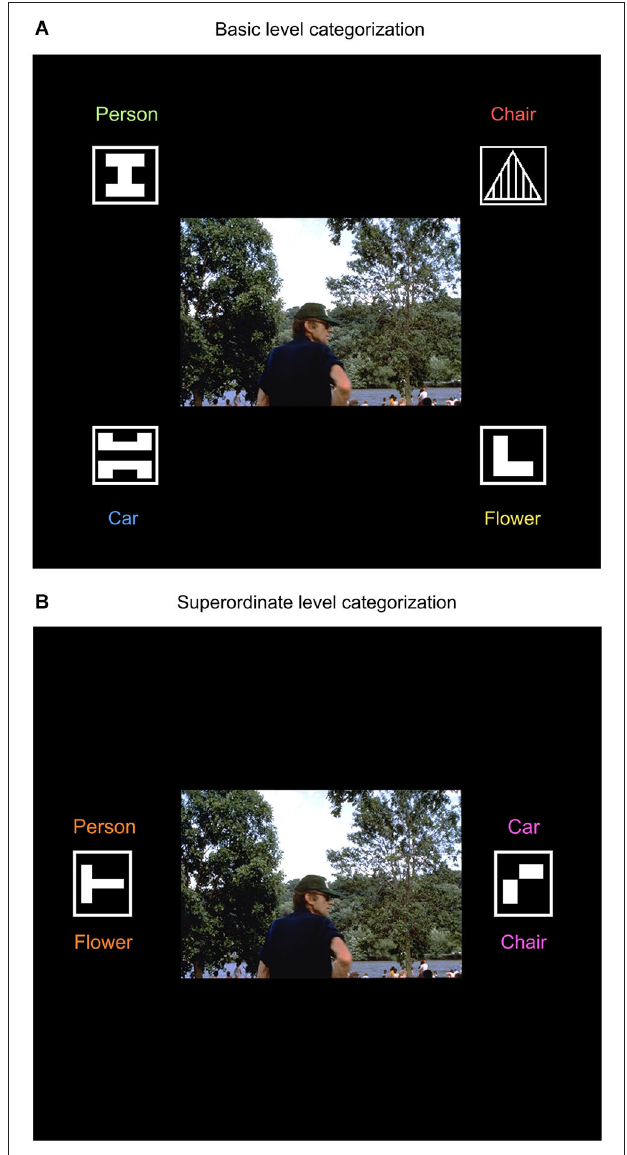
FIGURE 2 | Schematic layout of a basic-level categorization trial (A) and a superordinate-level categorization trial (B) in experiments studying pigeons’ ability to flexibly categorize the same object at different hierarchical levels